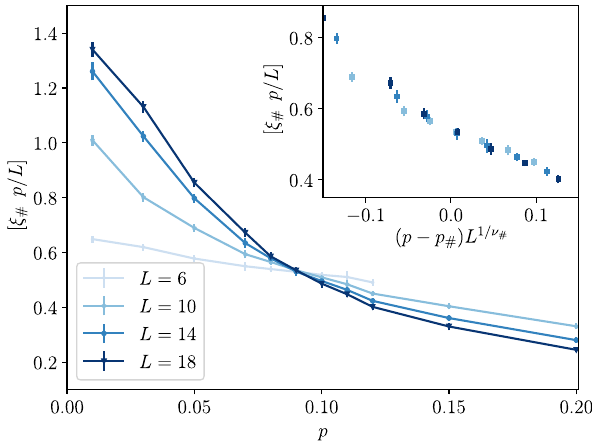
FIG. 17. Universal decay rate of charge-sharpening transition in qubit chains. Data and collapse of the decay rate in the vicinity of the charge-sharpening phase transition. The transition point p ¼ 0 . 088 and the critical exponent ν ¼ 2 . 15 established in the main text are used to collapse the